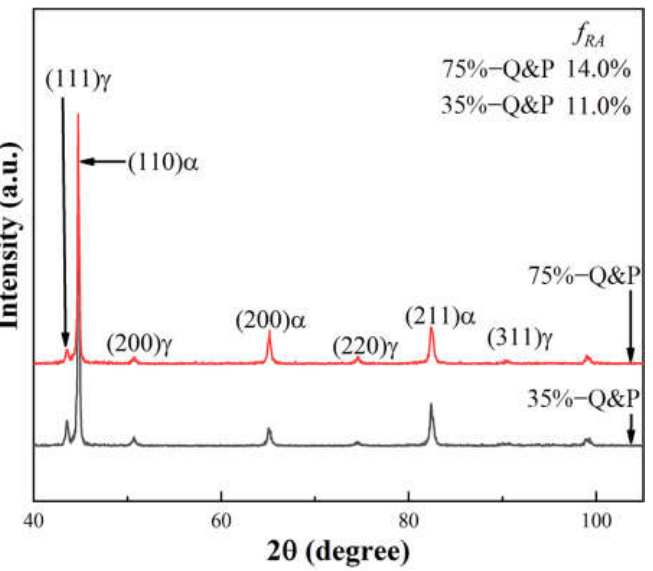
Figure 6. XRD spectra of 35%−Q&P sample and 75%−Q&P sample. The volume fractions of retained austenite of the two samples are presented in the figure.